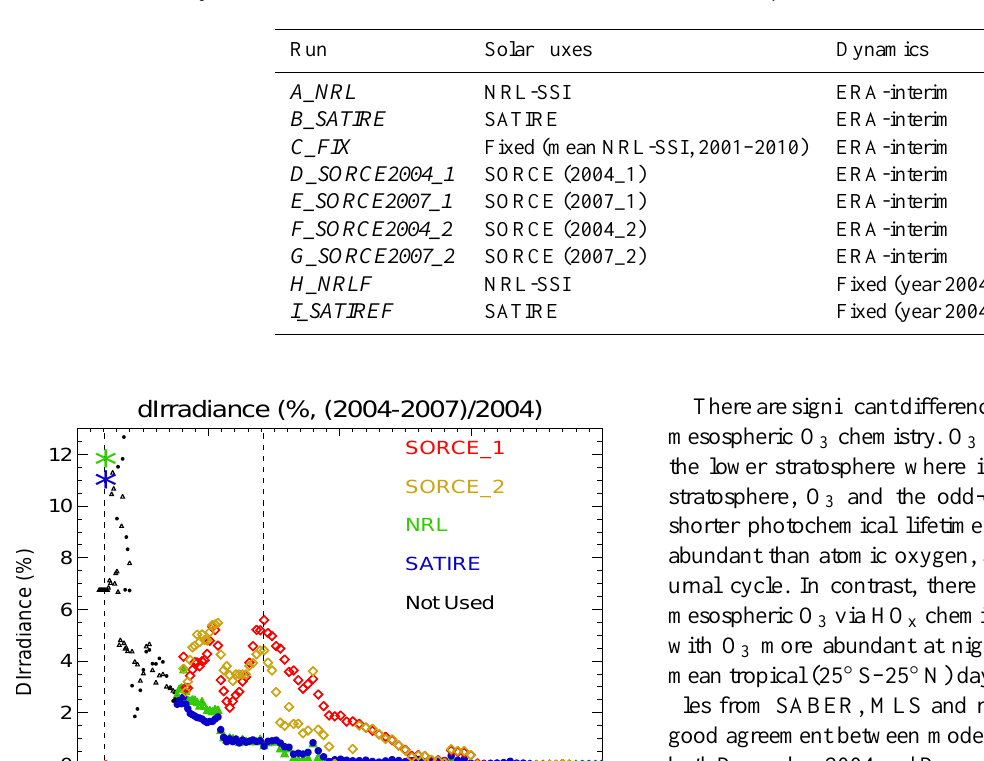
Table 1. Solar and dynamical conditions for the model simulations. All the runs are performed for the 2001–2010 time period.